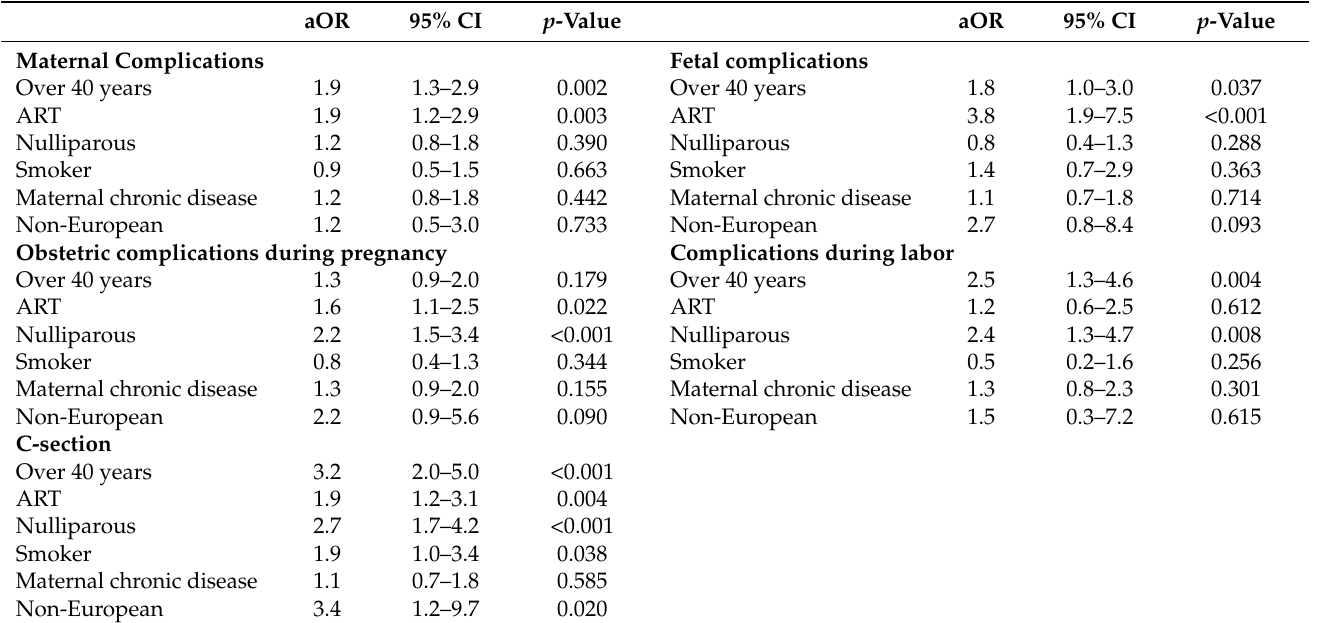
Table 4. Binary logistic regression models adjustment for confounders